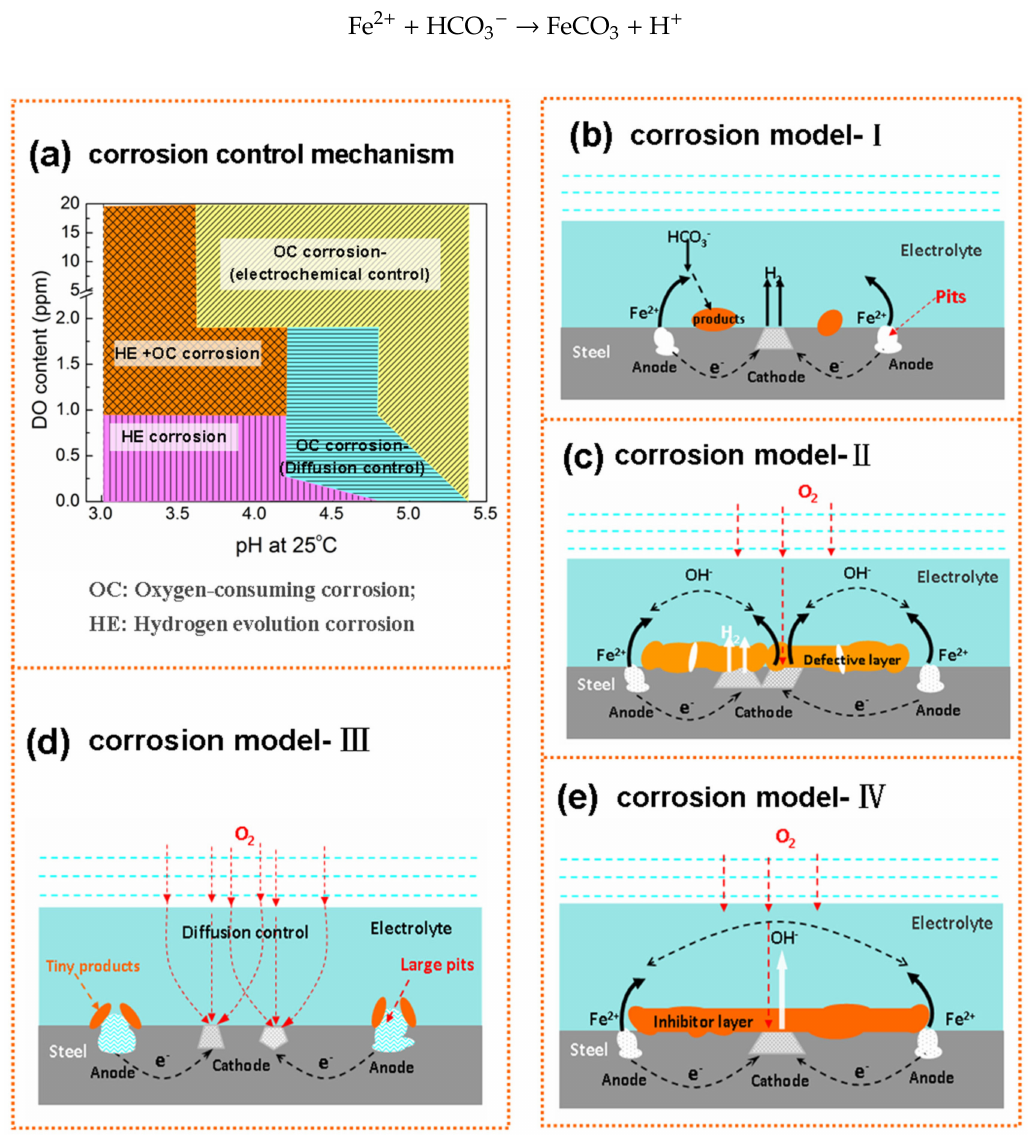
Figure 5. Corrosion control mechanism ( a ) and corrosion models ( b – e ) of X80 steel immersed in the acidic soil simulated solution with di ff erent level of pH and DO